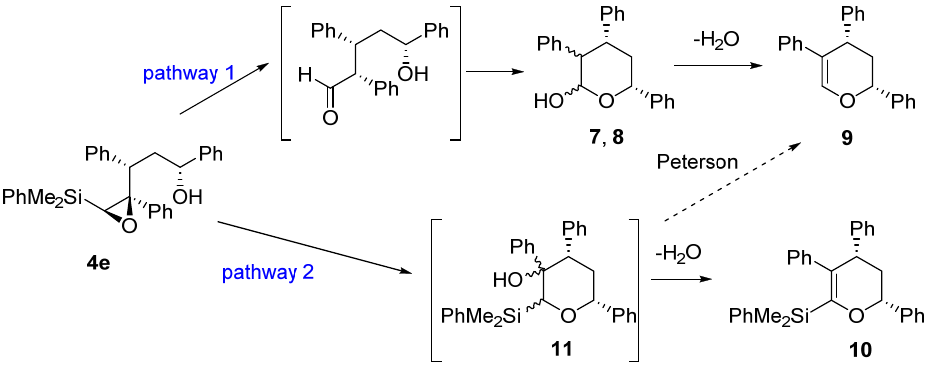
Scheme 5. Mechanistic proposal for the formation of products from the acid-catalyzed cyclization of 4e